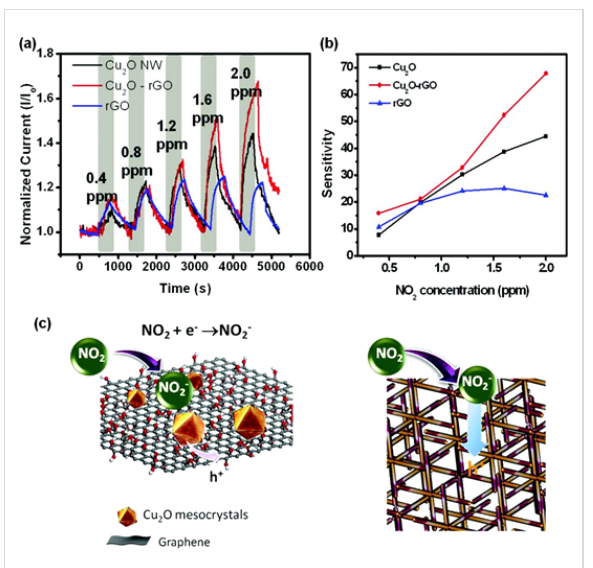
Figure 8: (a) Dynamic response of Cu 2 O NWs, rGO–Cu 2 O, and rGO devices under increasing NO 2 exposure. (b) The sensitivity of the NO 2 sensor for the three devices. (c) Schematic for the mechanism of NO 2 sensing of rGO–Cu 2 O. Reprinted with permission from [214], copy- right 2012 American Chemical Society.